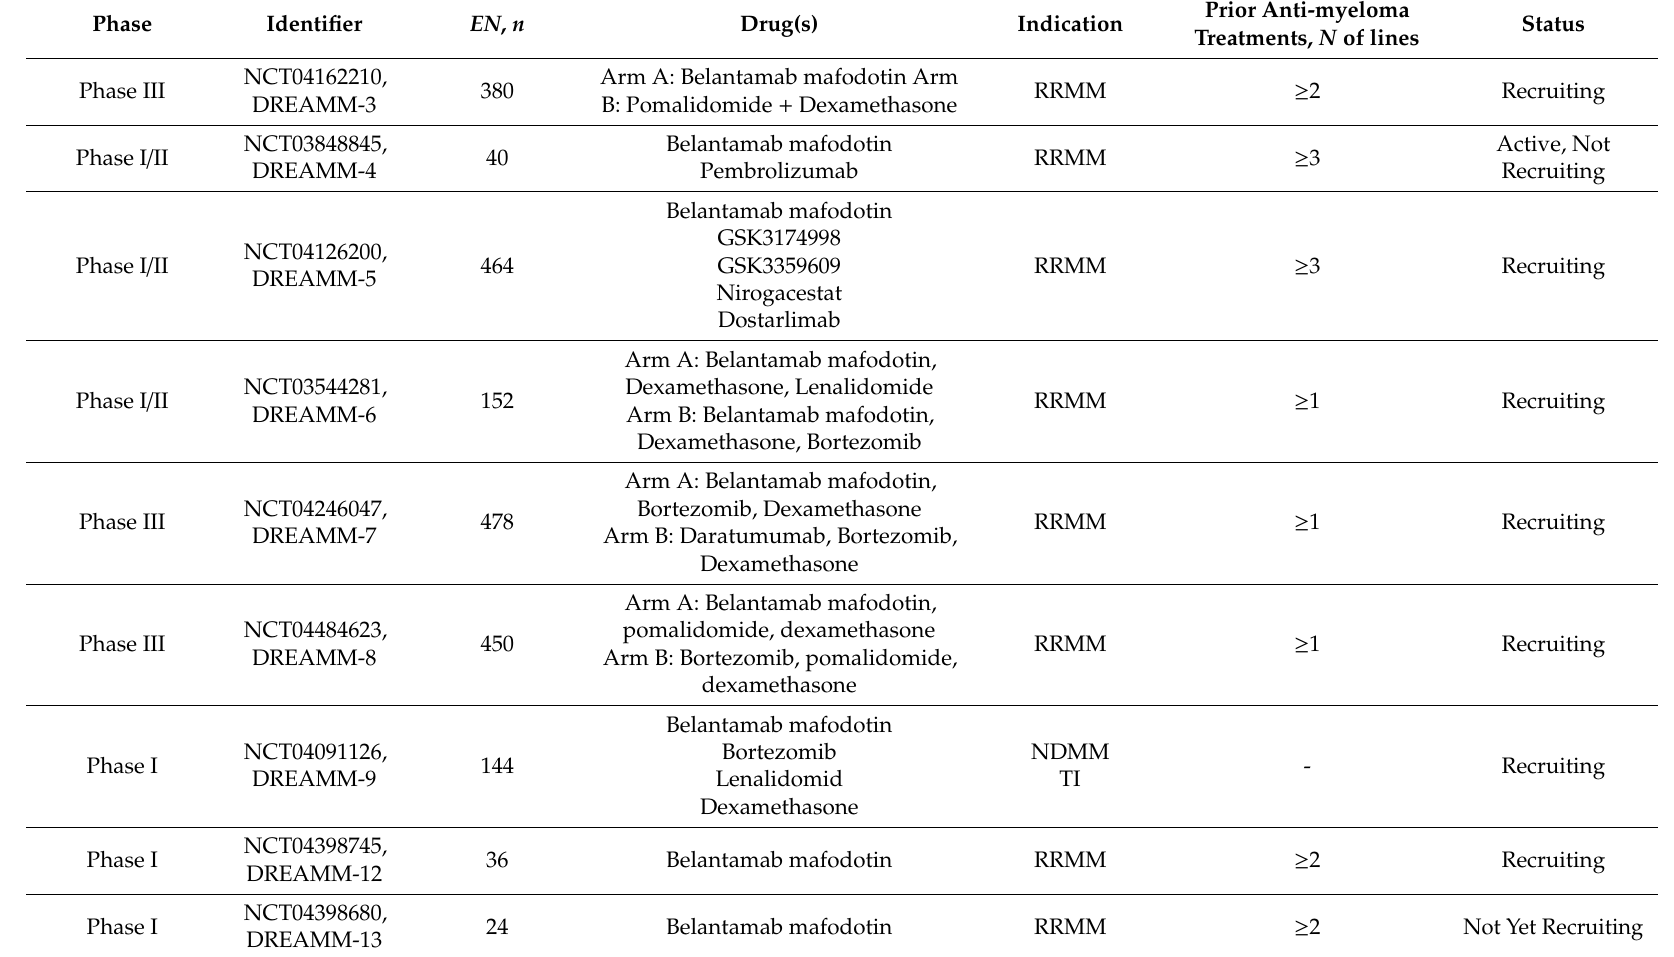
Table 3. Ongoing Clinical Trials of Belantamab Mafodotin in Multiple